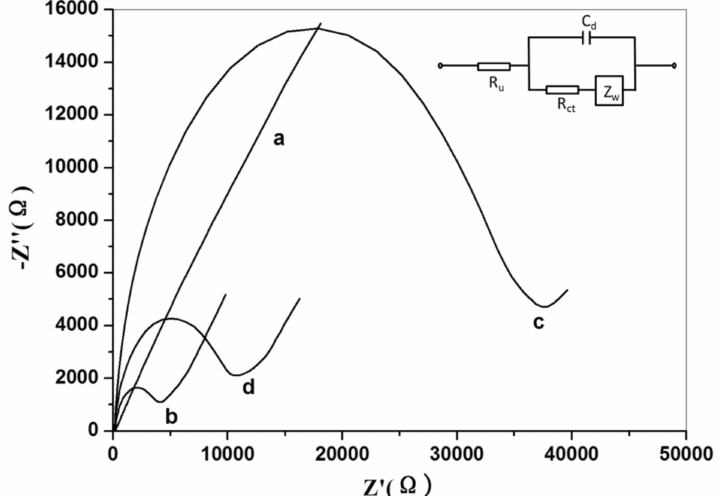
Figure 2. Nyquist diagrams of EIS at the bare gold electrode (curve a), the capture probe modified gold electrode (curve b), the aptamer probe modified gold electrode (curve c) and the aptamer probe modified gold electrode after reaction with 5.0 × 10 2 CFU/mL E. coli (curve d). EIS condition: frequency range: 100 kHz–0.01 Hz; potential: 0.175 V; amplitude: 5 mV; solution: 1 mM K 3 Fe(CN) 6 /K 4 Fe(CN) 6 containing 0.1 M KCl. The inset of Figure 2 is the Randles circuit model.